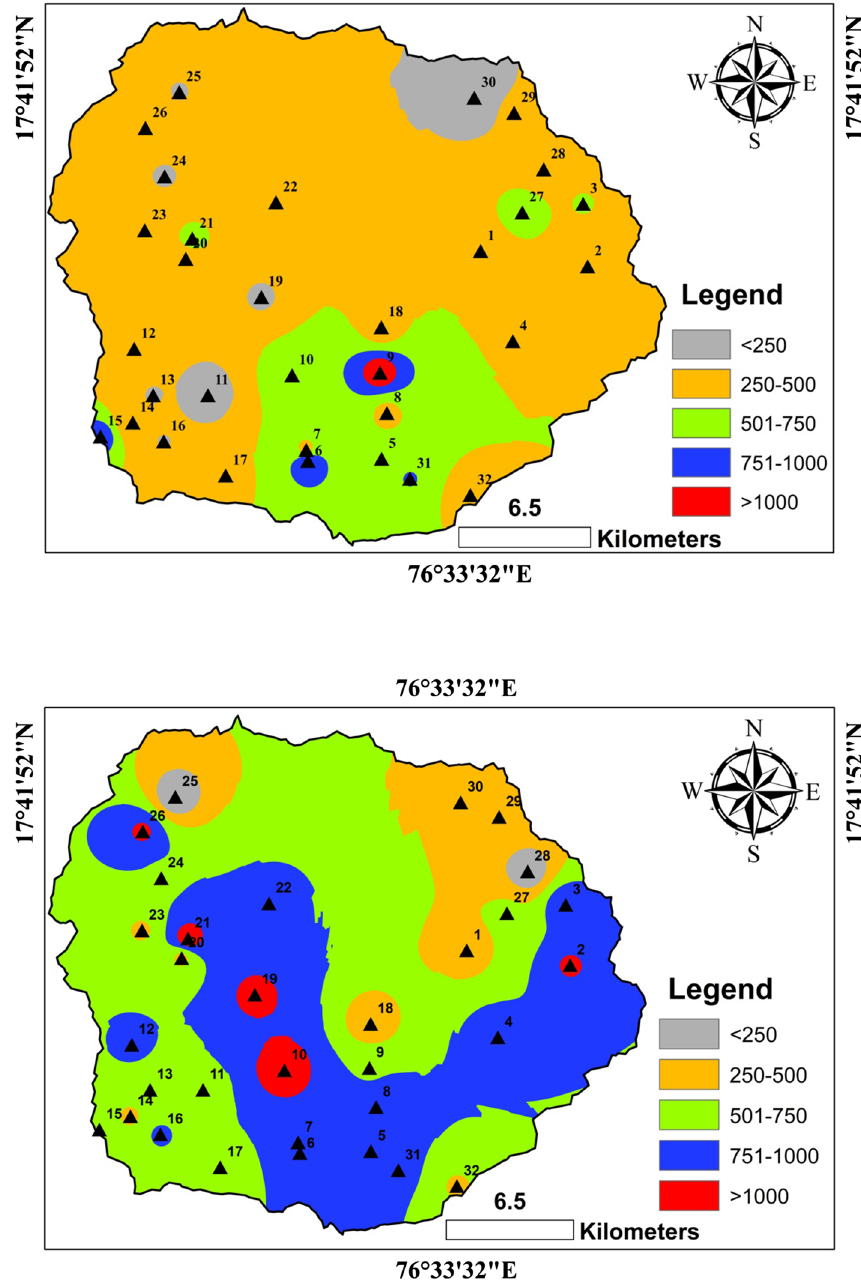
Fig. 4 Geospatial distribution of EC (pre-monsoon)